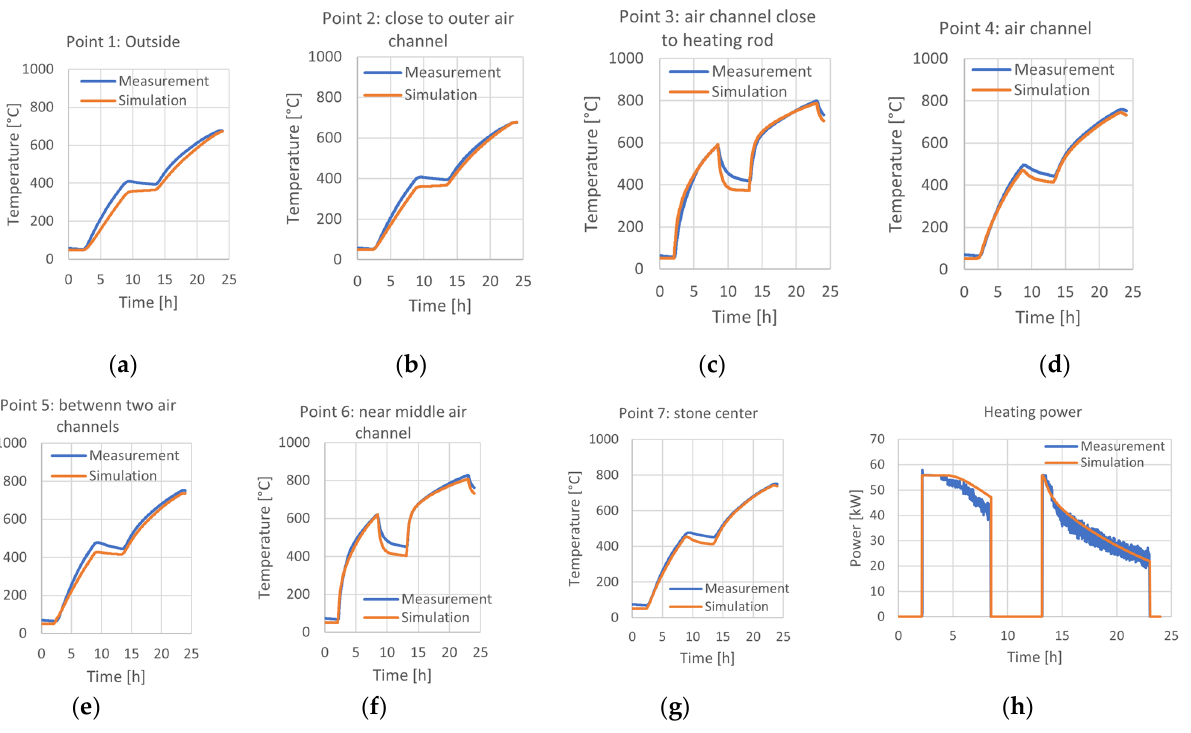
Figure 11. Graphical comparison of measured data and simulation data of the HTSS system.